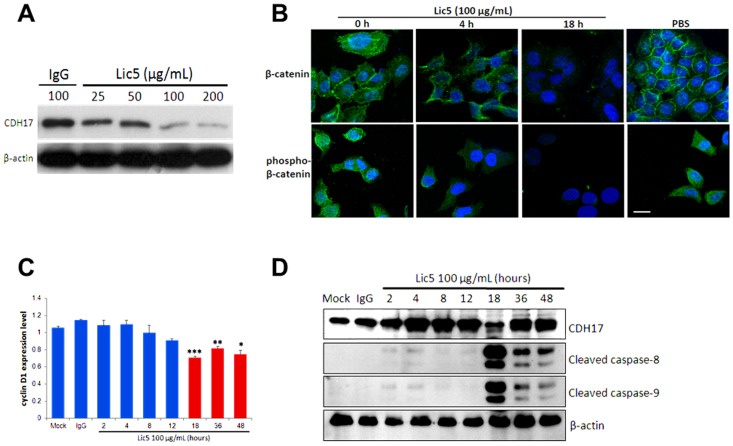

In vitro experiments of treating metastatic HCC cells with Lic5.Treatment of HCC cells with Lic5 inactivated CDH17/β-catenin signaling pathway and induced apoptosis. (A) MHCC97L cells with high level of CDH17 were treated with an increasing concentration of Lic5 from 25 to 200 µg/mL. A dose-dependent reduction in the protein level of CDH17 was detected using western blot. (B) Confocal microscopy images showed a reduction in cellular levels of total and phospho-β-catenin (at Thr41 and Ser45) proteins after Lic5 treatment in MHCC97H cells. PBS was used as a negative control. Scale bar, 20 µm. (C) Real-time qPCR showed a time-dependent reduction of cyclin D1 gene expression level in MHCC97H cells after treatment with Lic5 for 18, 36 and 48 hours.*, p = 0.001493; **, p = 0.00001424; ***, p = 0.00001377, when compared to the Mock (PBS) or IgG control. Shown are the representative set of data of three independent experiments, with each column represents the mean values of triplicate data. All p-values were calculated using ANOVA test of GraphPad PRISM. (D) Western blots showed treatment with Lic5 induced cleavage of caspase-8 and -9, but not by the Mock and IgG controls.